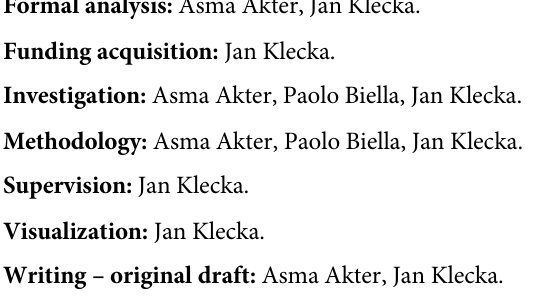
S1 Table. Data from the first experiment on flower visitation of individual plants with a variable number of flowers. S2 Table. Data from the second experiment on flower visitation of clusters of multiple plants. S3 Table. Detailed data on foraging behaviour of honeybees. S4 Table. Data on honeybee handling time per flower: Feeding time and total time spent per